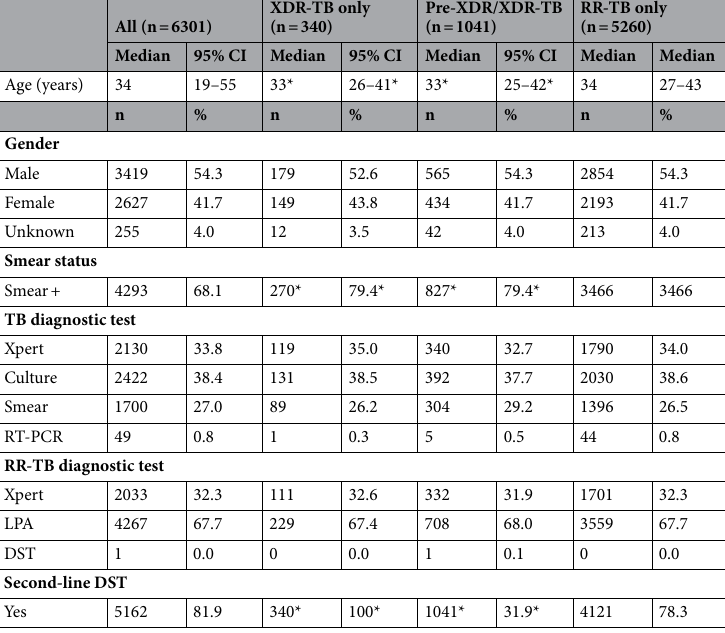
Table 1. Baseline characteristics of individuals with RR-TB (mappable to clinic) in Western Cape, South Africa. *Significant p-value (XDR-TB group or pre-XDR/XDR group vs. RR-TB only) based on Wilcoxon t-test